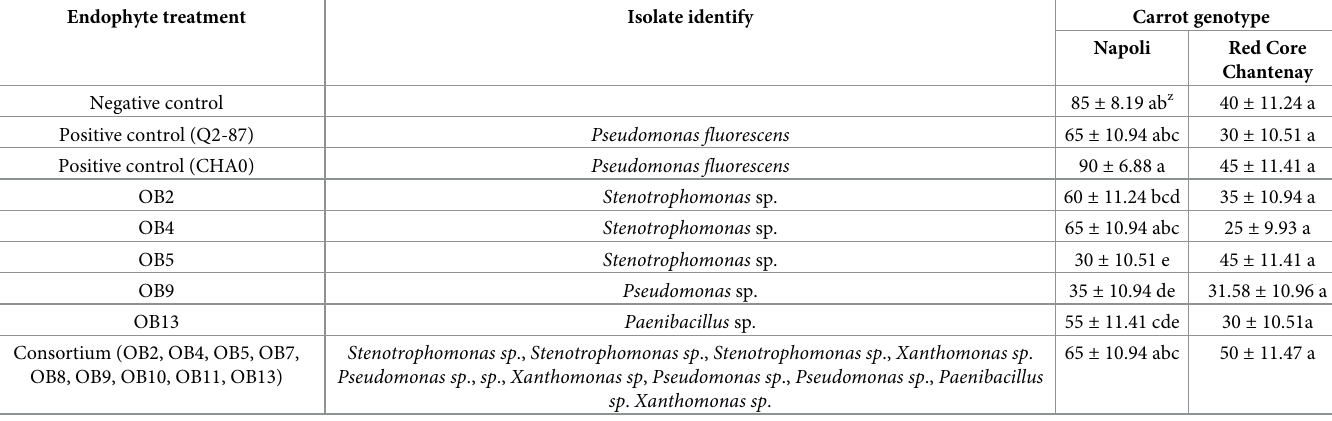
Table 5. The effect of seed treatment with endophytic bacterial isolated from carrot taproots on the % germination of two carrot varieties in greenhouse trials. Endophyte